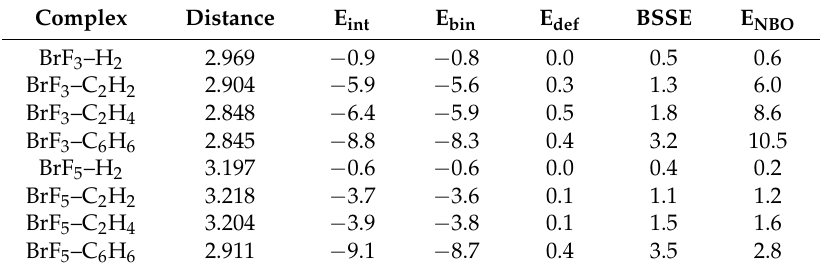
Table 1. The energetic parameters of complexes analyzed (all in kcal/mol); interaction energy, E int , binding energy, E bin , deformation energy, E def , Natural Bond Orbital (NBO) energy, E NBO and the BSSE correction; the distance between Lewis base and Lewis acid units is included (in Å). Complex Distance E int E